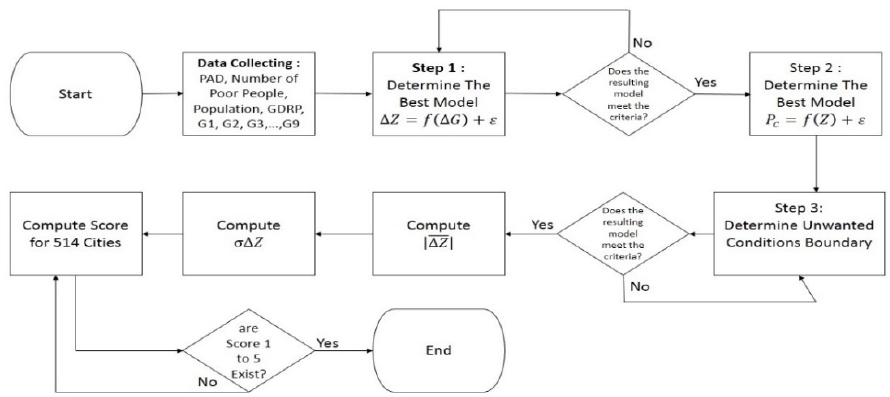
Figure 1. Workflow diagram describing sequence of steps involved in method for measuring a city’s economic